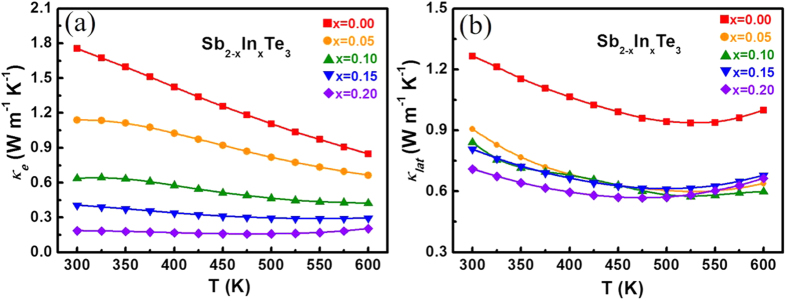
(a) Carrier thermal conductivity and (b) lattice thermal conductivity of Sb2−xInxTe3 (x = 0–0.2).